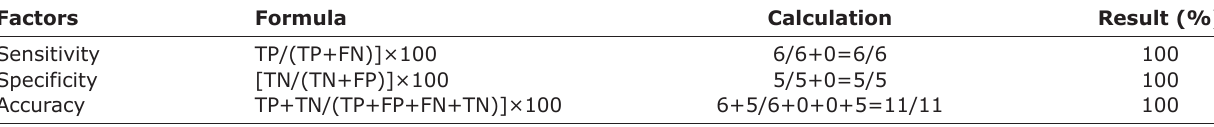
Table-5: Test results of IHC.